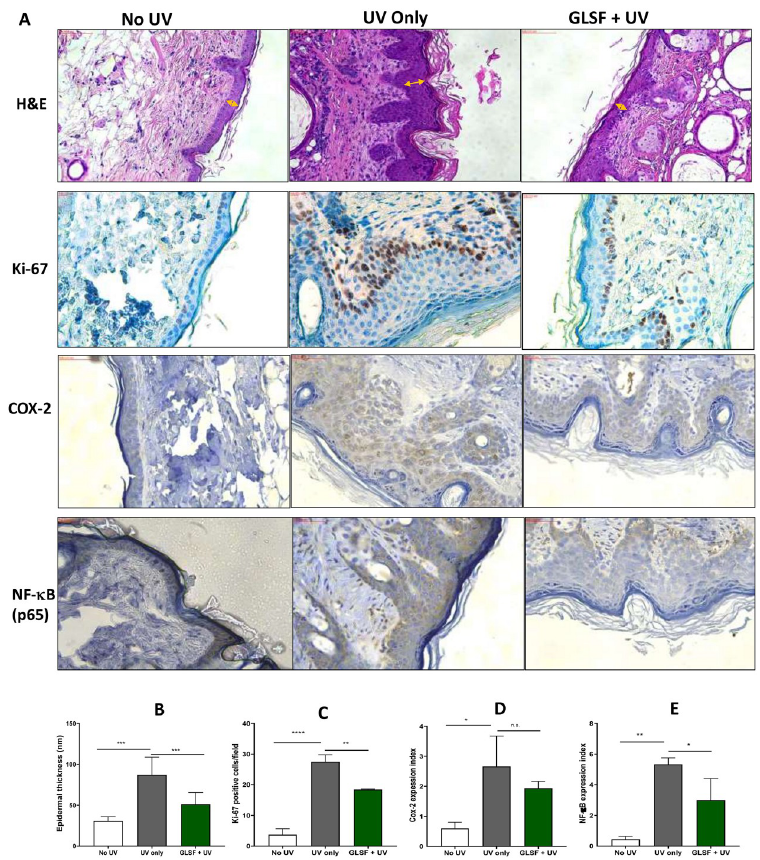
Fig 3. Effects of GLSF and UV on histology and inflammatory markers in non-tumor skin in SKH-1 mice. (A) Representative microphotographs of skin of mice treated with UV, with or without GLSF treatment stained with H&E (40X) and IHC of Ki-67, COX-2 and NF- κ B (p65) (40X). For IHC, brown color indicates specific immunostaining of Ki-67, NF- κ B and COX-2 and light blue color indicates hematoxylin staining. (B) Measurement of epidermal thickness in H&E-stained slides of mice. The thickness was measured 10 times at various locations along with the epidermis and averaged to obtain a single skin sample data (n = 5). (C) Quantification of the number of Ki-67 positive cells, which were counted in three randomly selected fields and averaged to obtain a single skin sample data (n = 5). (D) and (E) The expression index was used to quantify the extent and intensity of COX-2 and NF- κ B-p65 expression in each skin sample (n = 5). An ANOVA followed by a Tukey-Kramer multiple-comparison post hoc test was used to assess statistical differences at p < 0.05.